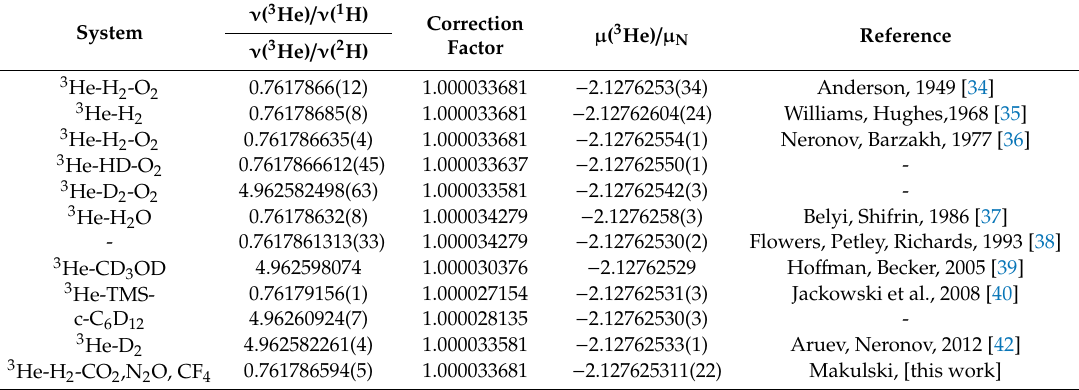
Table 1. Nuclear magnetic moment of helium-3 from nuclear magnetic resonance (NMR) spectroscopy.